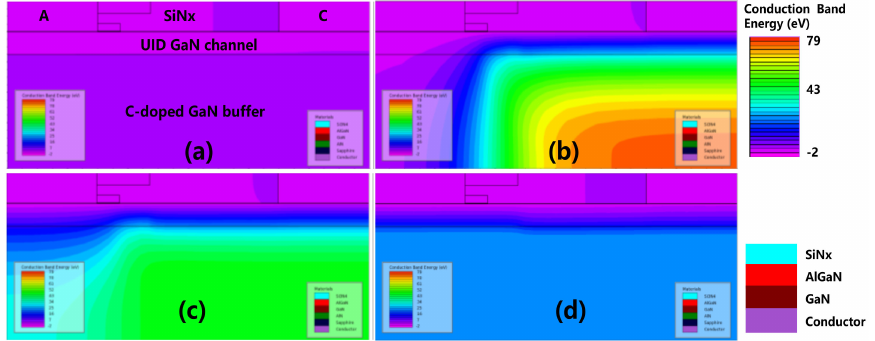
Figure 6. The conduction band energy distribution at different timings. ( a ) t 0 : the initial state; ( b ) t 1 ; ( c ) t 2 ; and ( d ) t 3